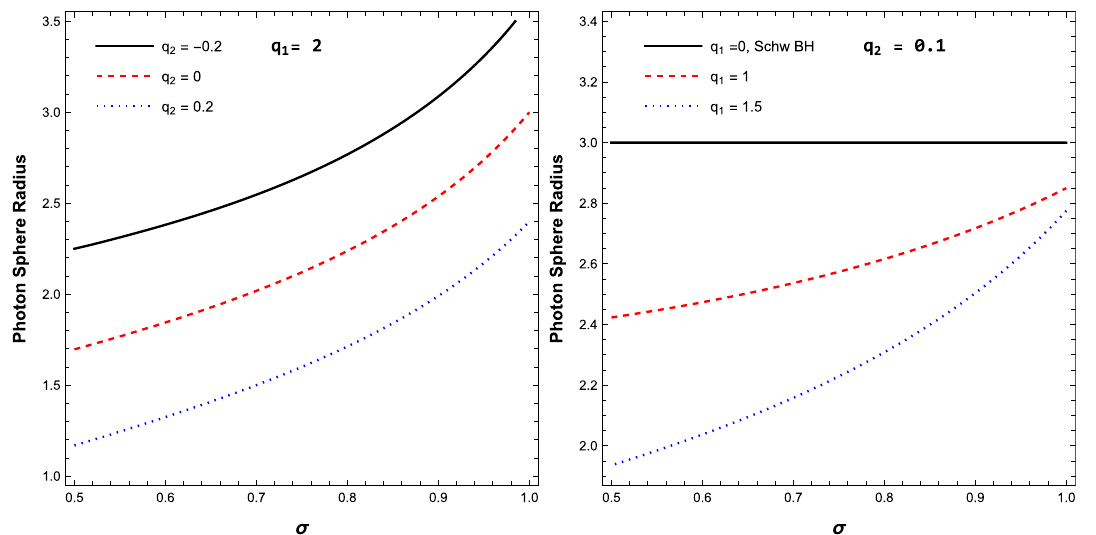
Fig. 6 Variation of photon sphere radius with increase of the param- eter σ , for selected values of q 1 and q 2 . In the left plot q 1 is fixed and q 2 takes three different values while in the right plot, q 2 is fixed and q 1